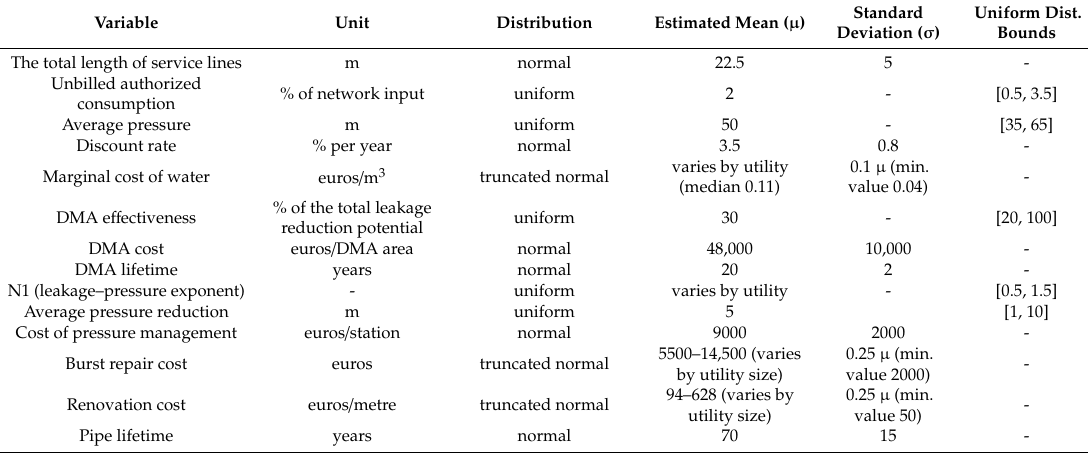
Table 2. The distributions of variables in the uncertainty analysis. DMA: district metered areas.